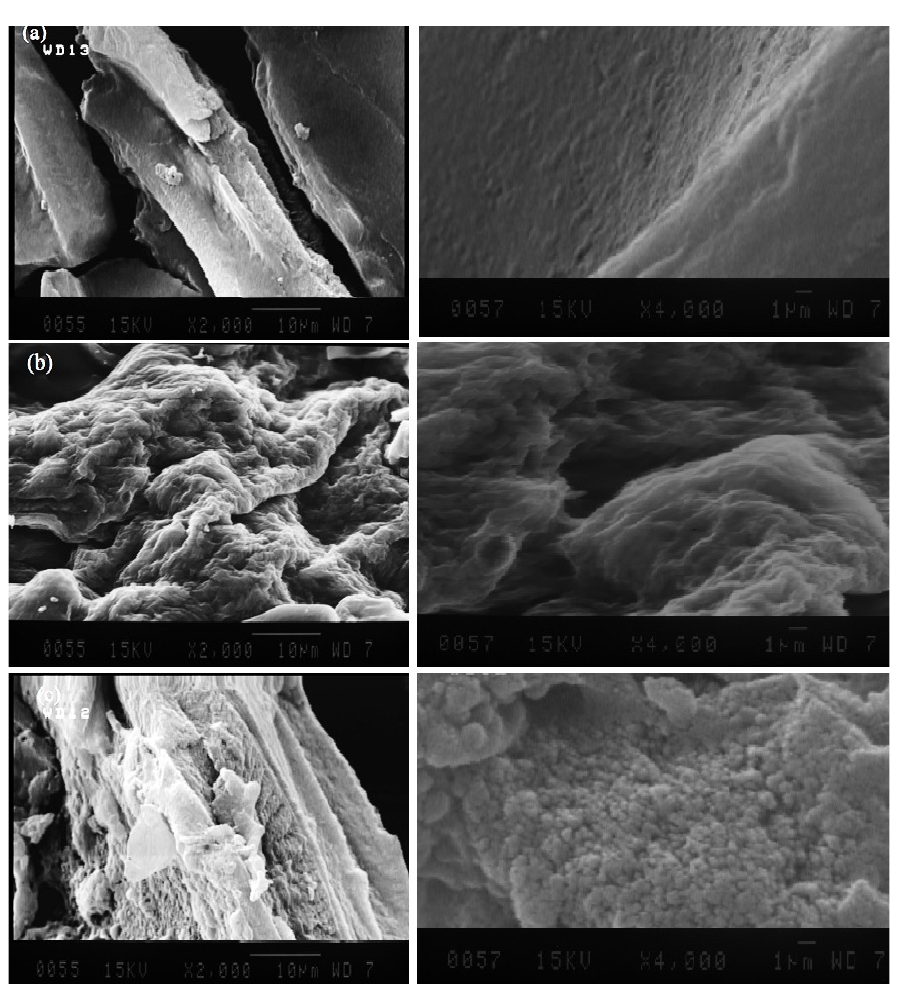
Fig. 4. SEM images of (a) GO, (b) RGO.3, and (c) RGO.10 with different magnifications (Scale bar 10 and 1 μm